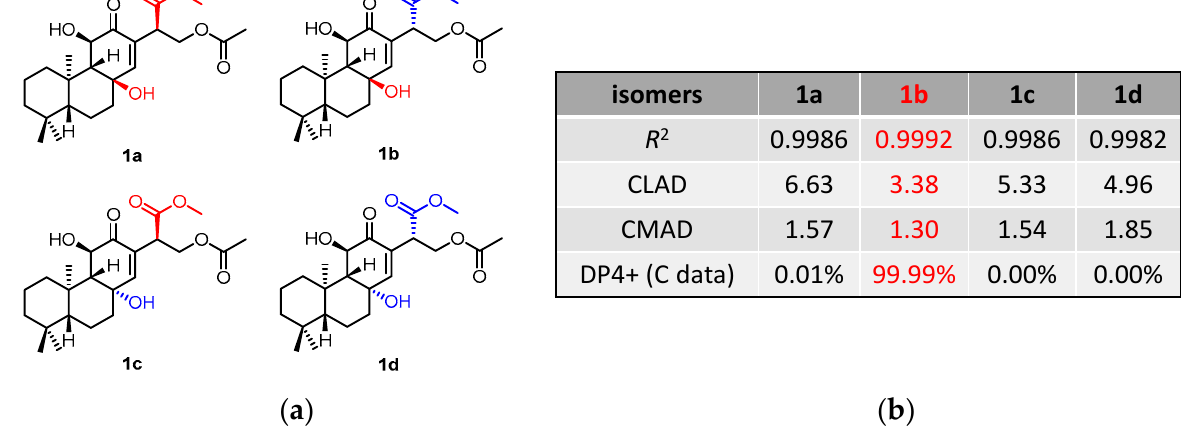
isomers isomers